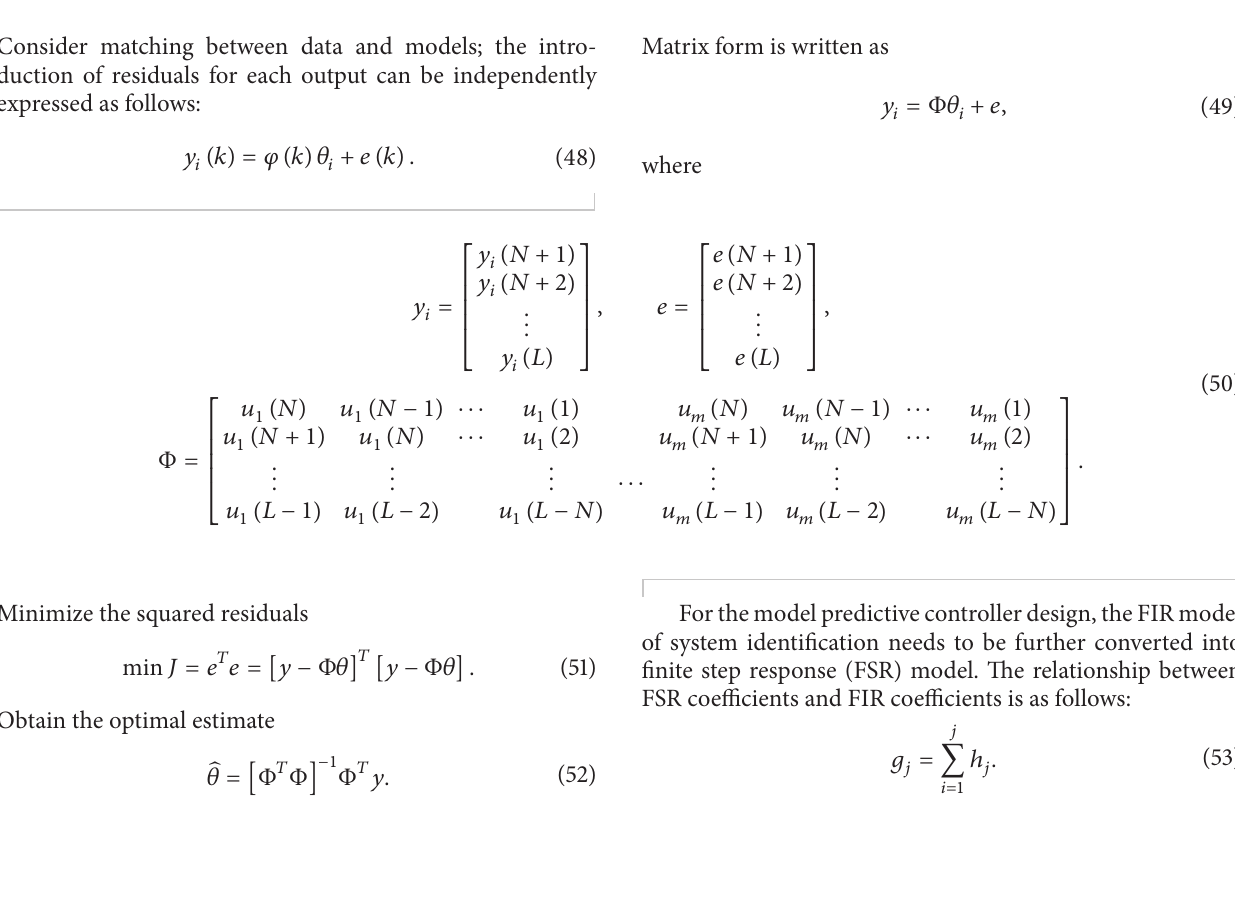
Figure 5: Reactor temperature prediction result and relative error under reactor flow rate 𝐹 𝑜